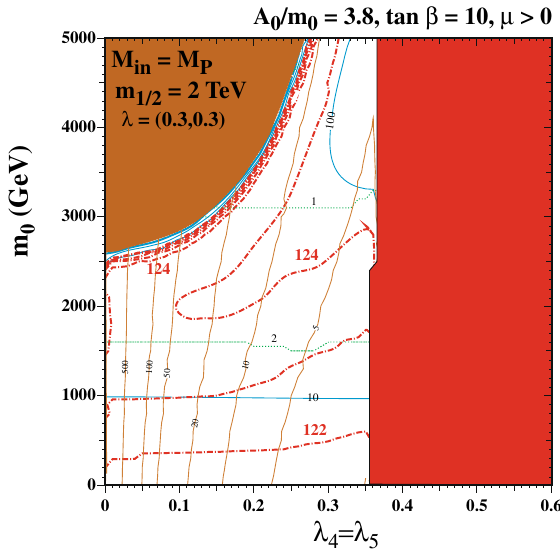
Fig. 8 Representative ( λ 4 = λ 5 , m 0 ) planes in the FSU(5) GUT model, both with A 0 / m 0 = 3 . 8. In the left panel M in = 10 16 . 5 GeV with m 1 / 2 = 7 TeV, whereas in the right panel M in = M P with m 1 / 2 = 2 TeV. The brown shaded regions are excluded because the